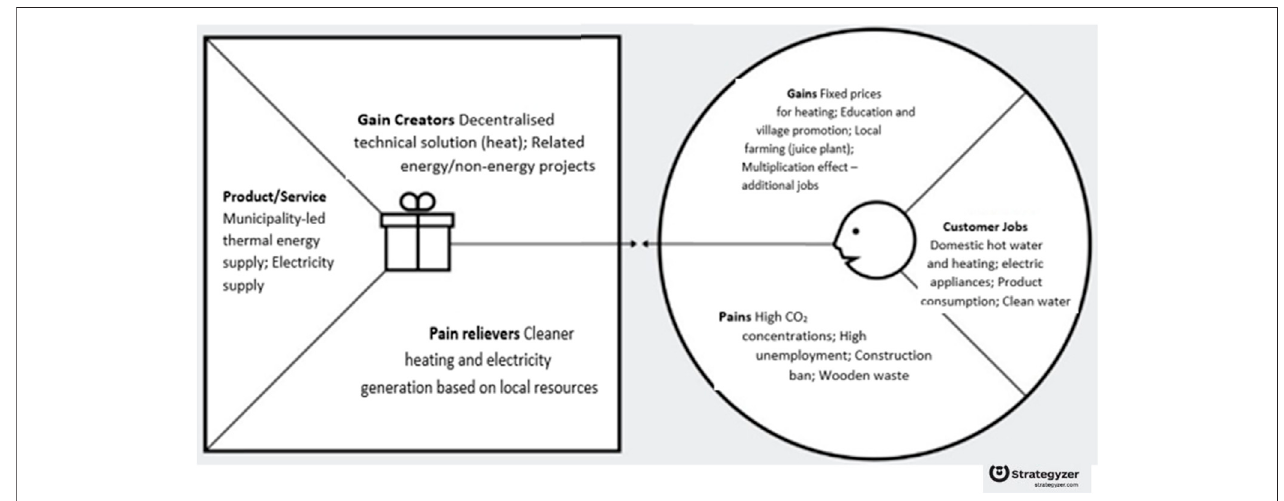
FIGURE 4 | Value proposition canvas (municipality-NPO) based on Osterwalder et al. (2014), Strategyzer.com, and with copyright by Strategyzer